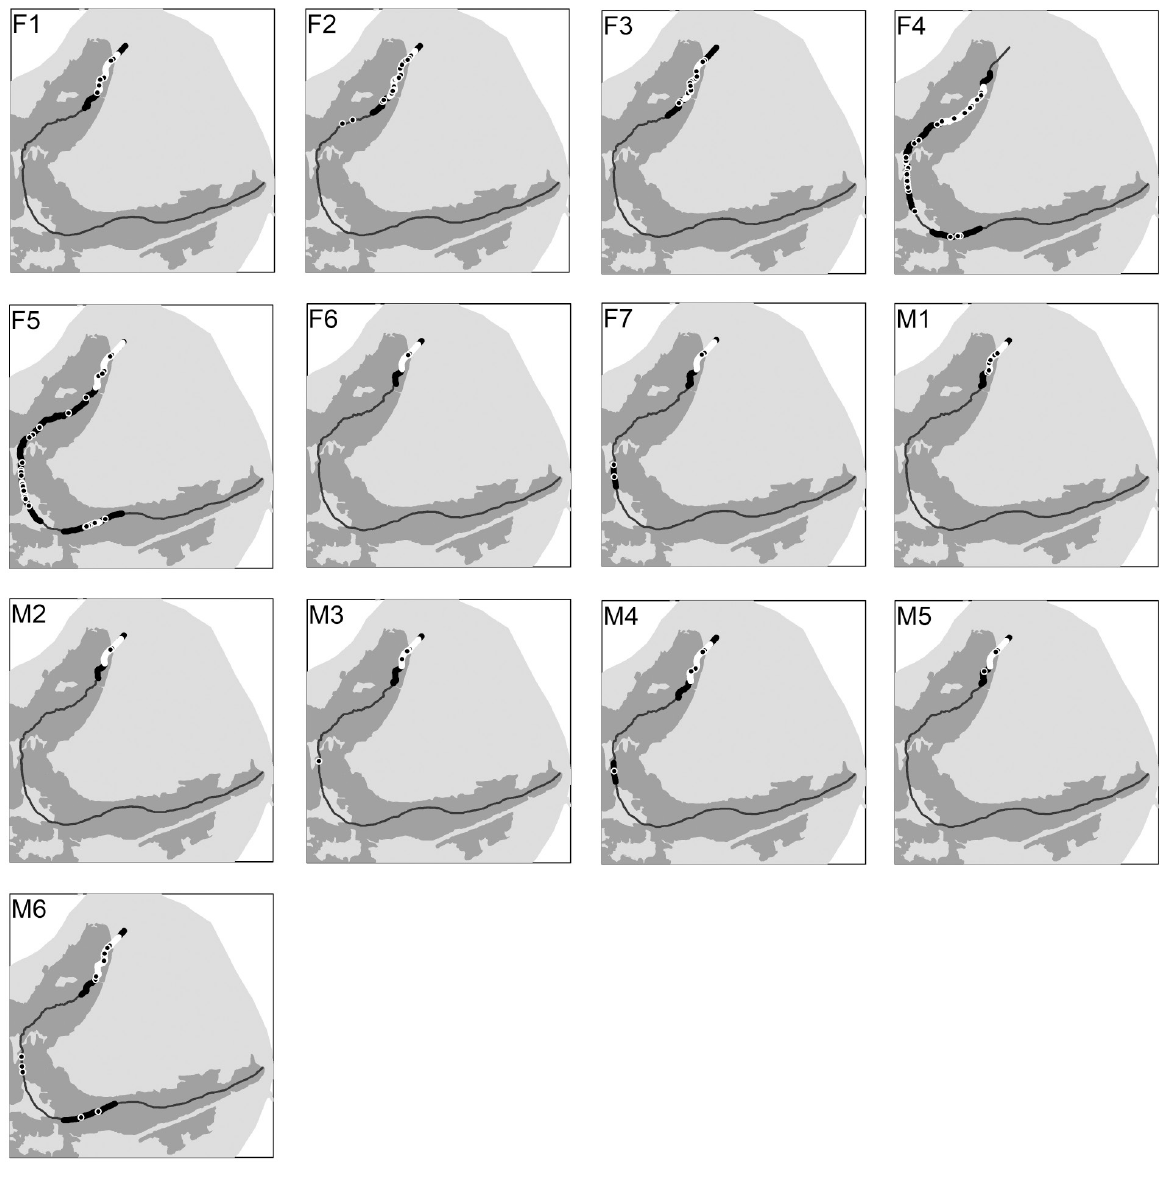
Figure 2. Home range of seven females (F1–F7) and six males (M1–M6) of Phrynops geoffroanus . White area – 1D Kernel 50%; Black area – 1D Kernel 95%; Dark grey – water bodies; Medium grey – forested area; Light grey – not forested area; Black circles – individual observations of P. geoffroanus